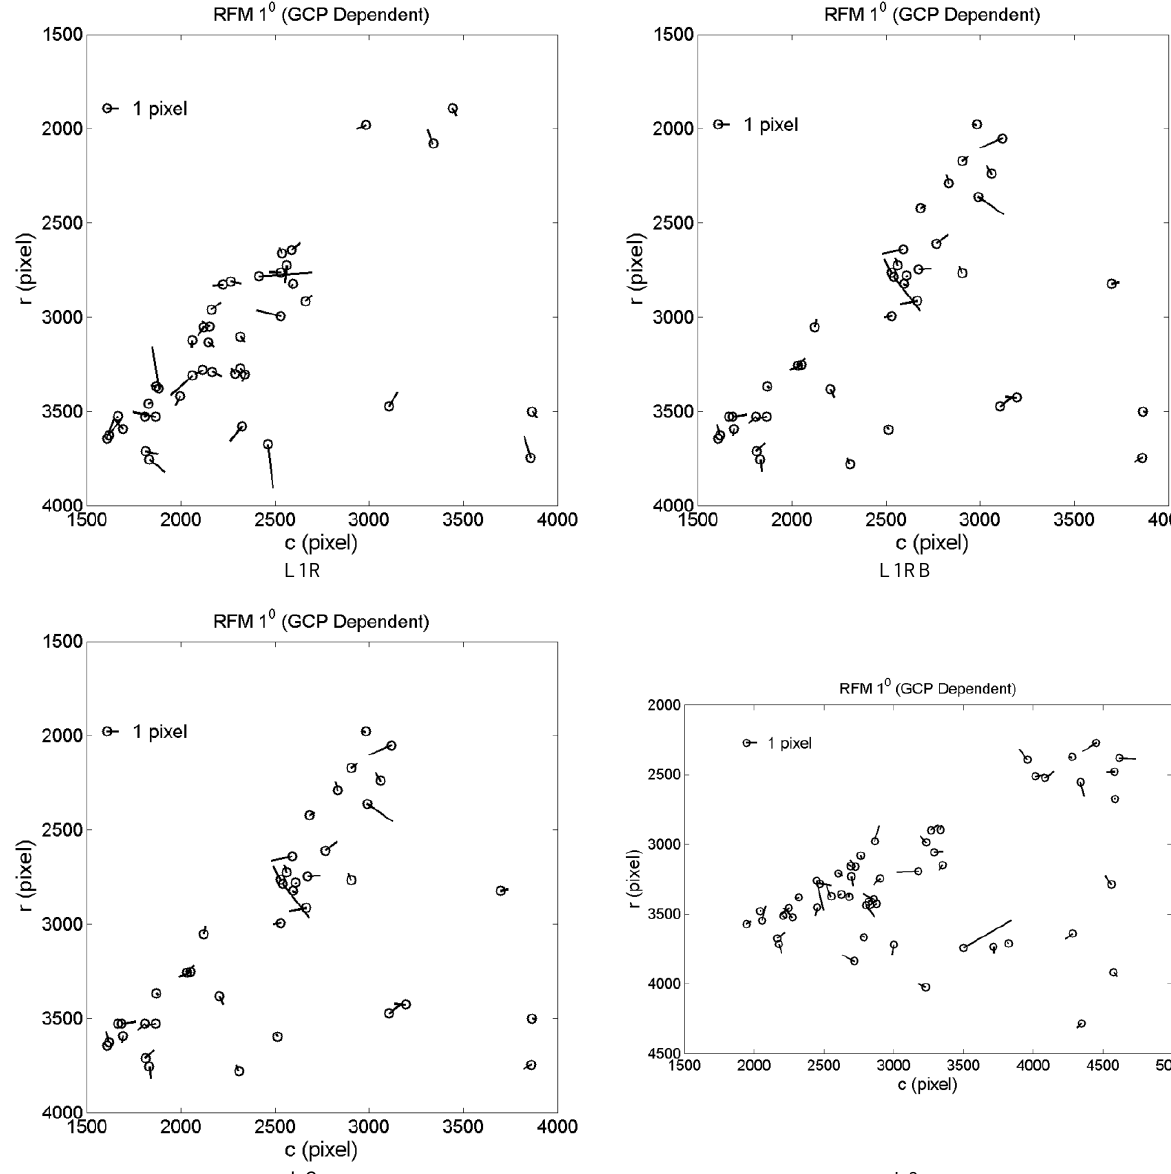
Figure 5. Error vectors derived by 1st order RFM for all